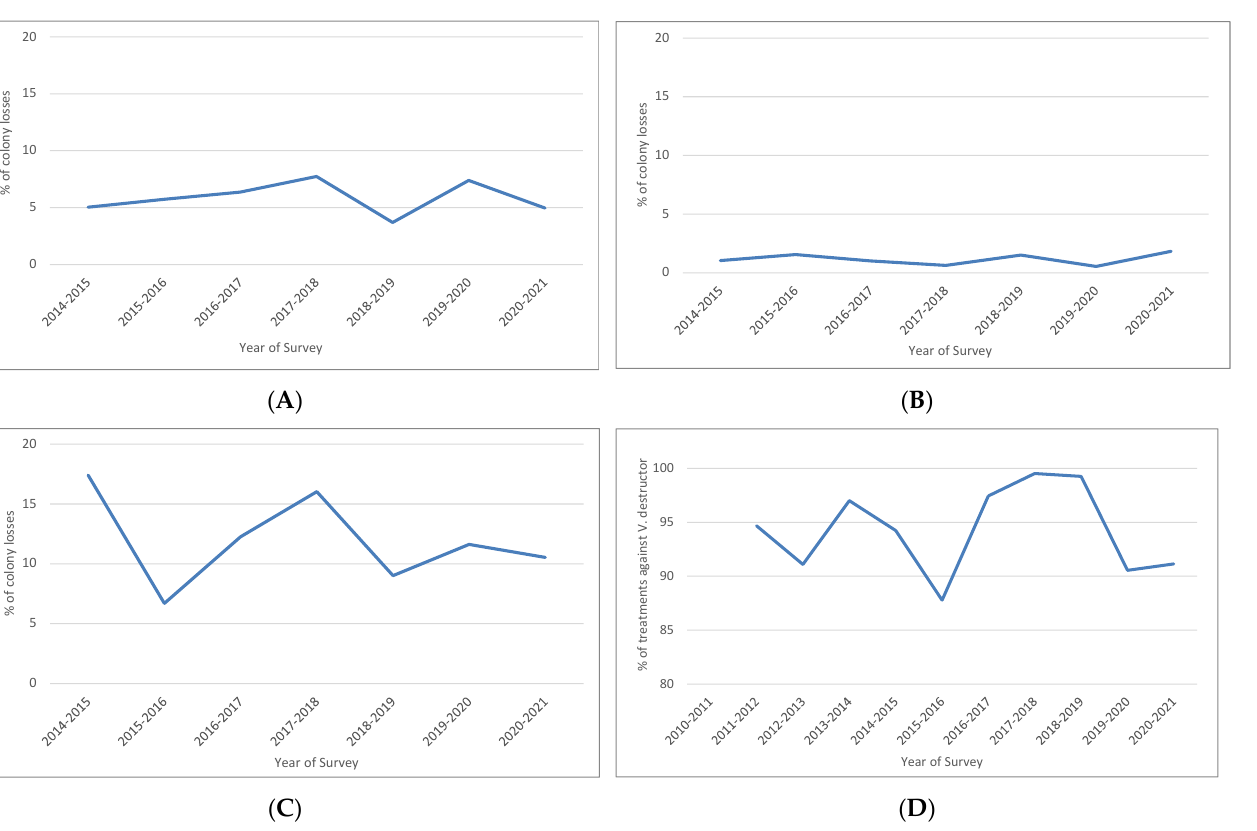
Figure 1. ( A ) Percentage of colony losses due to queen-related problems. ( B ) Percentage of colony losses due to natural disasters. ( C ) Percentage of losses arising from dead or empty colonies. ( D ) Percentage of treatments against V. destructor carried out by respondents.